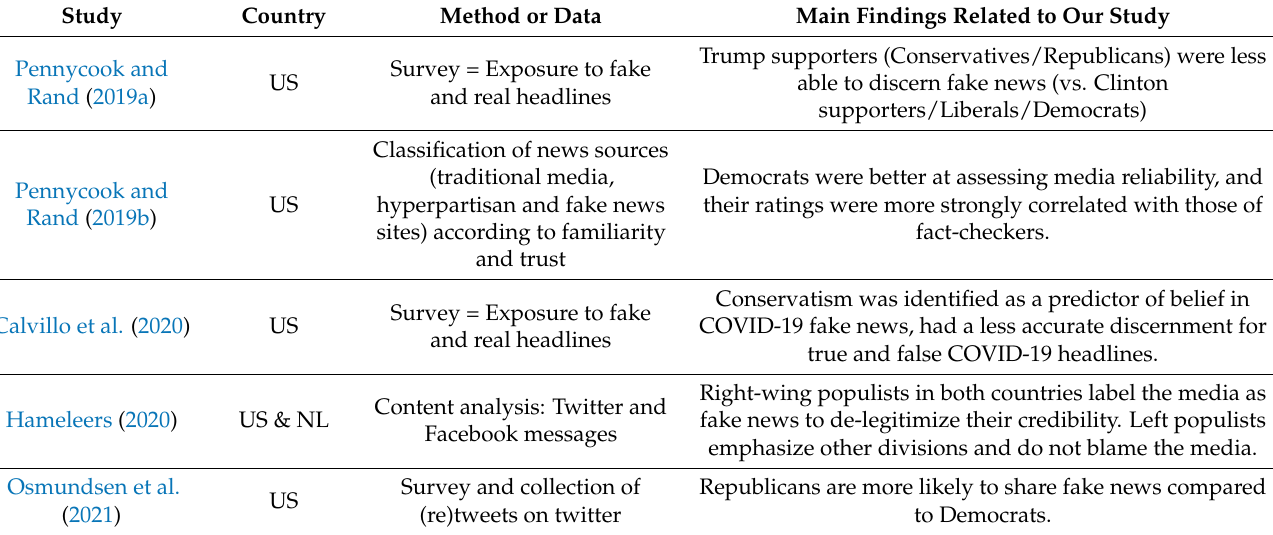
Table 1. Political asymmetry in the discernment of fake news